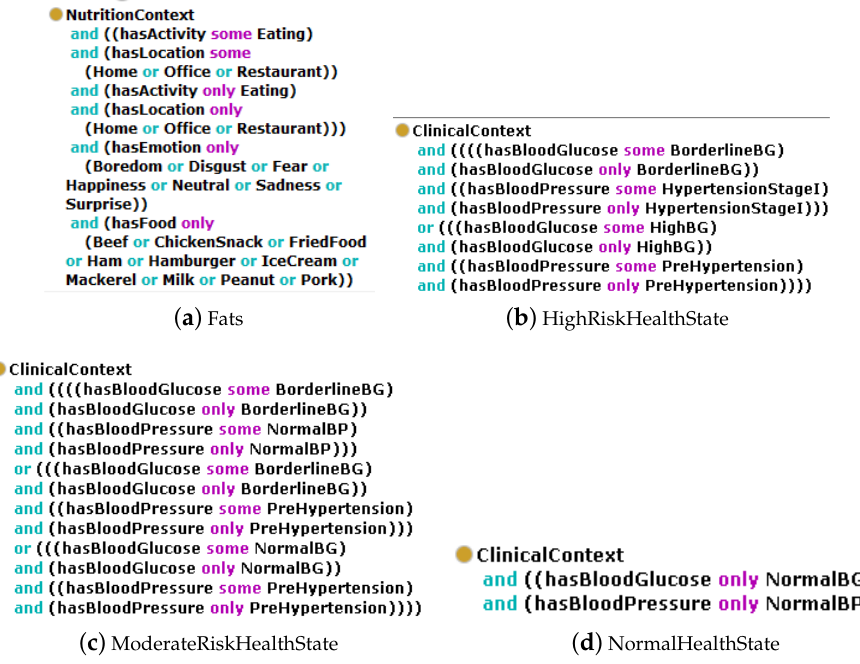
Figure 3. MMCO: Some of example for definitions of the NutritionContext and ClinicalContext are